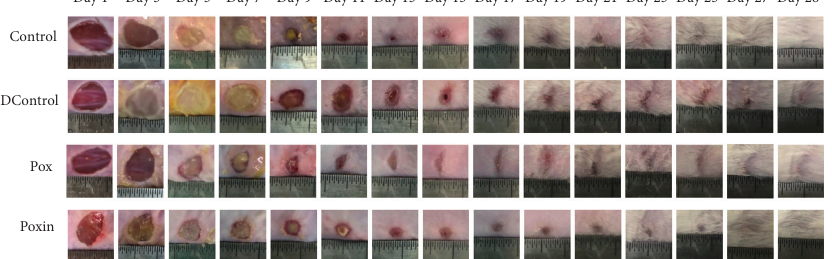
Figure 3: Wound closure of animals in Control, DControl, Pox, and Poxin. Wound closure was documented with a digital camera at a fixed distance every other day from day 1 to day 28 of the operation in all study groups.